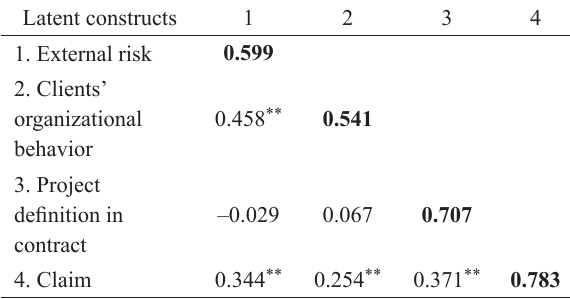
Table 5. Discriminant validity assessment of latent constructs